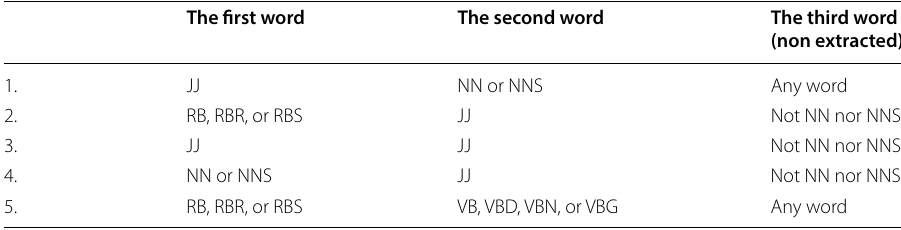
Table 2 POS labeled rules [9] The first word The second